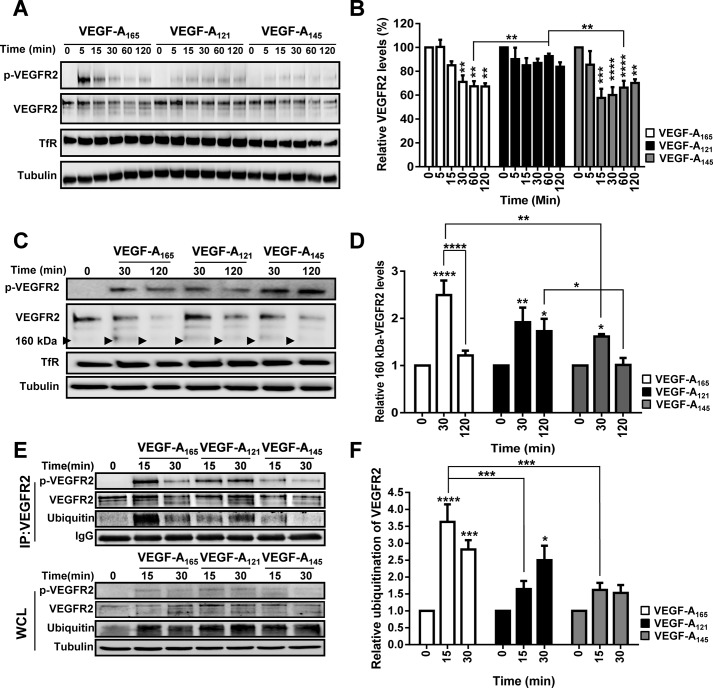
VEGF-A isoform-specific regulation of ligand-stimulated VEGFR2 degradation, proteolysis and ubiquitylation. (A) Endothelial cells were stimulated with either VEGF-A165, VEGF-A121 or VEGF-A145 (1.25 nM) for 5, 15, 30, 60 or 120 min before lysis and processing for immunoblot analysis to assess total VEGFR2 levels. (B) Quantification of total VEGFR2 levels upon VEGF-A isoform stimulation. (C) Endothelial cells were stimulated with either VEGF-A165, VEGF-A121 or VEGF-A145 (1.25 nM) for 30 or 120 min before lysis and processing for immunoblot analysis to assess VEGFR2 proteolysis. Black arrowheads denote ∼160 kDa proteolytic fragment. (D) Quantification of VEGFR2 160 kDa proteolytic fragment (arrowheads in C) levels upon VEGF-A isoform stimulation. (E) Endothelial cells were stimulated with either VEGF-A165, VEGF-A121 or VEGF-A145 (1.25 nM) for 15 or 30 min before being subjected to immunoprecipitation using an antibody against total VEGFR2 (IP:VEGFR2). Whole cell (WCL) or IP:VEGFR2 lysates were processed for immunoblot analysis to assess VEGFR2 ubiquitylation status using an antibody against poly-ubiquitin (FK2). Tubulin or IgG were used as loading controls for WCL or IP lysates respectively. (F) Quantification of VEGFR2 ubiquitylation status upon VEGF-A isoform stimulation. Error bars indicate ±s.e.m. (n≥3). *P<0.05, **P<0.01, ***P<0.001, ****P<0.0001.